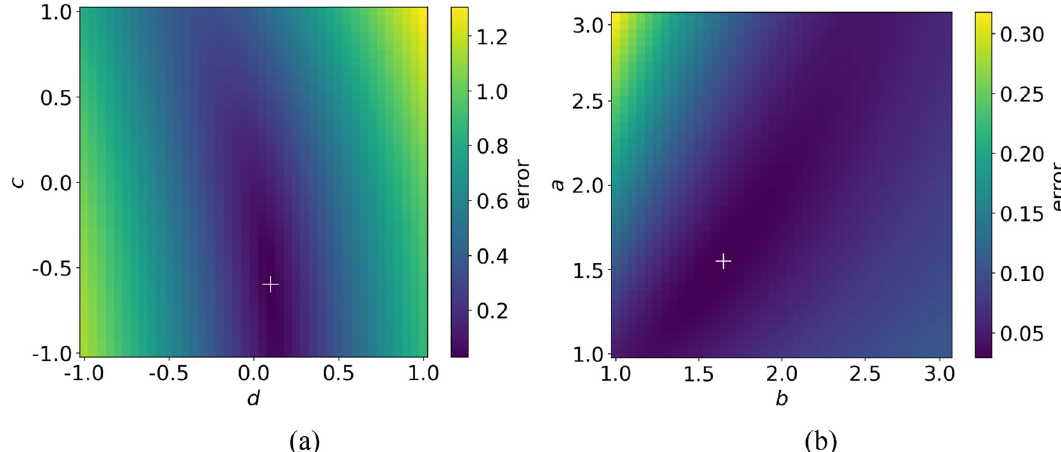
Figure 18. Effect of the model parameters a, b, c, d on the error between model results and the experimental results. In ( a ), c and d are fixed as − 0.62 and 0.10. In ( b ), a and b are fixed as 1.54 and 1.65. The white cross represents the position of minimum error.